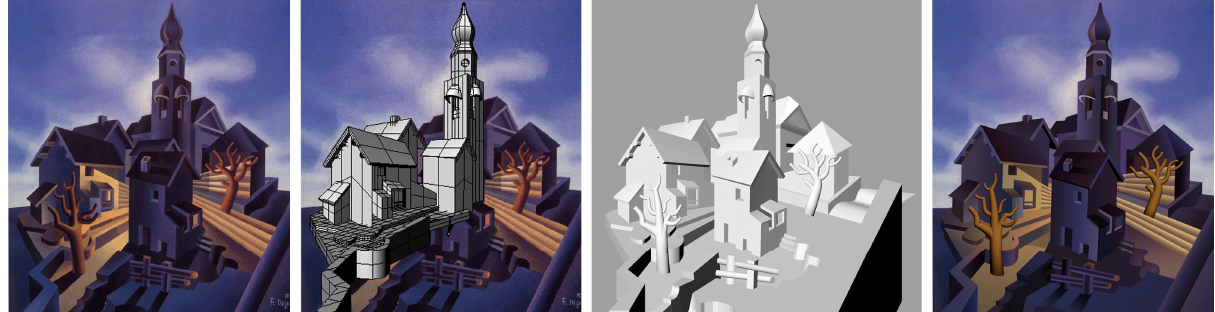
Figure 5. “Case alpestri in blu” (Fortunato Depero): from the picture to the digital model and its virtual image construction (author: Tiziana Bianchi)